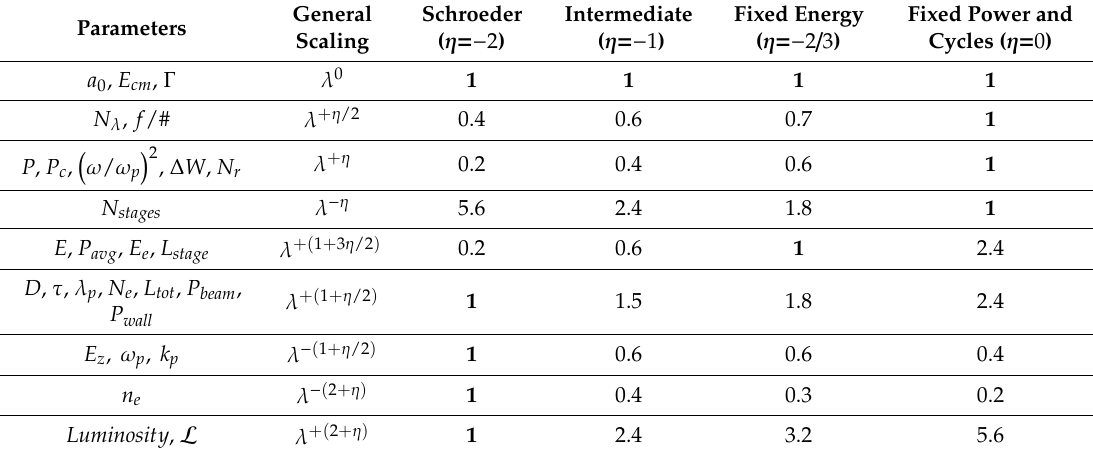
Table 1. Net scaling of laser, plasma, and accelerator parameters with laser wavelength. The first column lists the various parameters (see the Appendix A for a list of symbols), the second lists the general wavelength scaling, and columns 3–6 show specific values of the relative scalings for a laser wavelength change from 0.8 µ m (Ti:S) to 1.9 µ m (Tm:YLF), a factor of 2.4 × . Unity values are in bold to highlight parameters fixed by the particular choices of the scaling parameter η